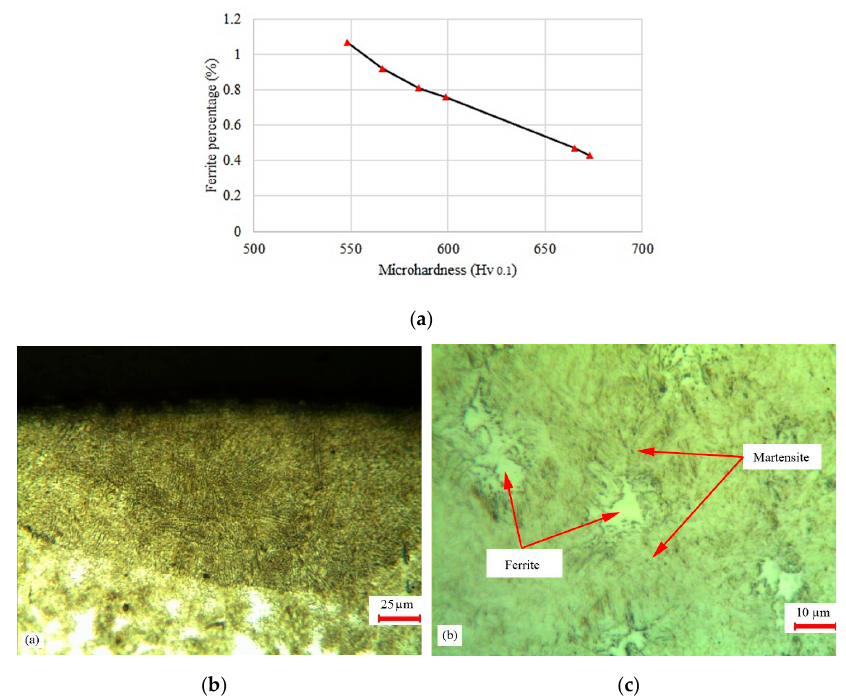
Figure 12. Microstructure of the LH zone of samples #5 and #9. ( a ) 50 × of sample #5; ( b ) 100 × of sample #5, ( c ) 50 × of sample #9; ( d ) 100 × of sample #9.